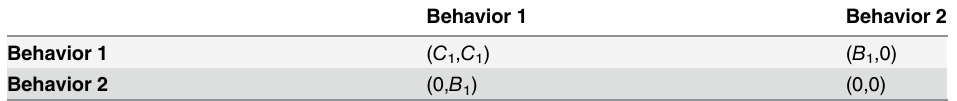
Table 1. The Payoff Matrix of the Interactions in Small Group 1(Simplified Form).